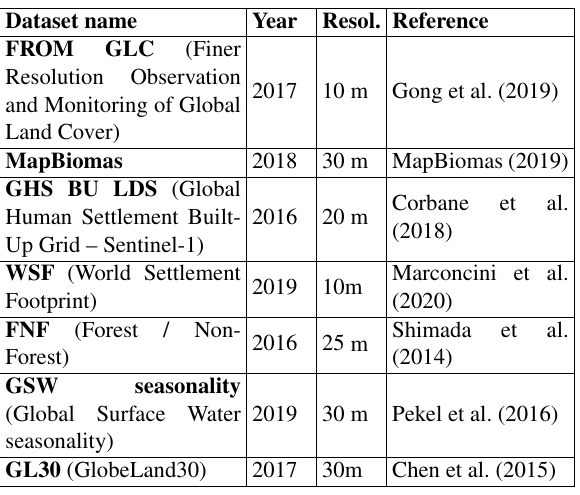
Table 3: Existing high-resolution land cover dataset Every land cover map aims at representing material on the Earth’s surface as accurately as possible. Nevertheless, every map con- tains certain errors depending on imagery type, preprocessing,